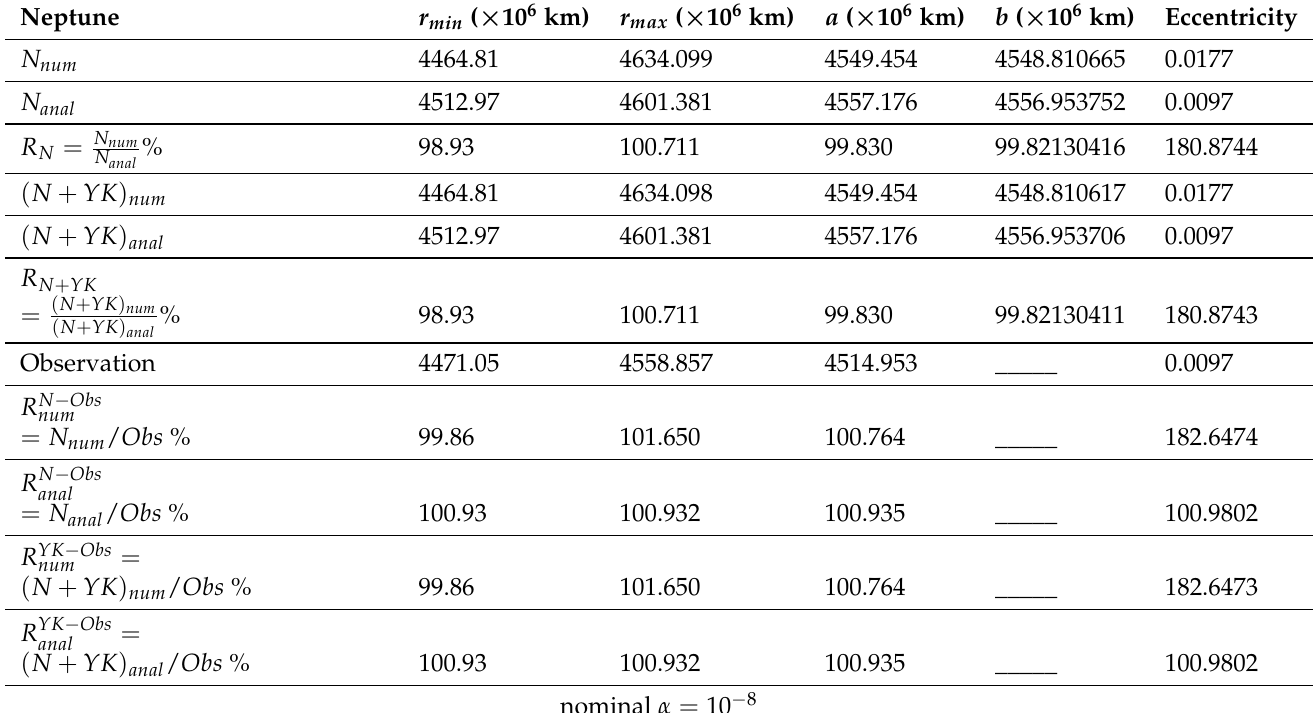
Table A15. The values of the calculated and observational astronomical parameters, for nominal α , of the planet, Neptune whose number of moons is